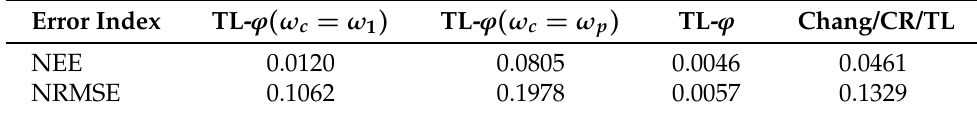
Table 7. Displacement errors for m 50 ( ˜ ω = 6 rad/s, %).